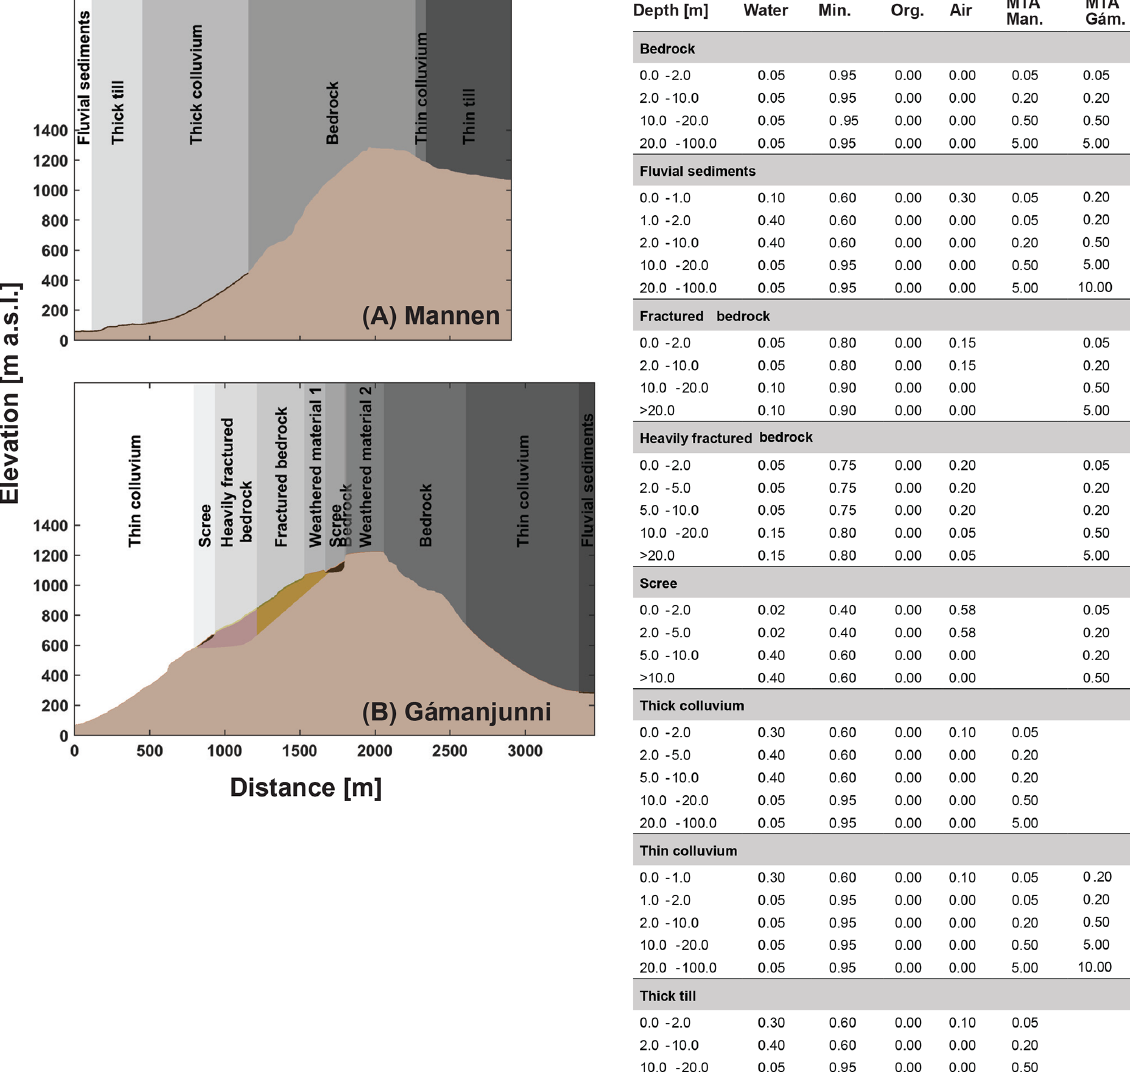
Figure A1. The subsurface regions and parameterisation for the 2D thermal modelling for (a) the Gámanjunni-3 and (b) Mannen profile. MTA: maximum triangle area, which is a measure describing the spatial resolution of the triangles in the employed finite-element method solver. The table shows the stratigraphy chosen for the different regions, along with the depth parameterisation and volumetric contents of water–ice, mineral, and organic and air components following Westermann et al.